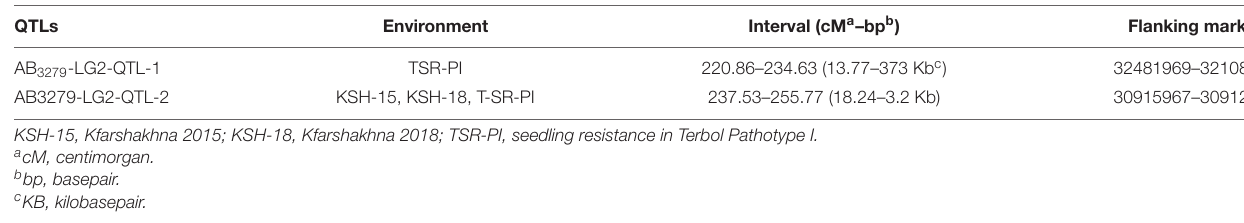
FIGURE 3 | Chromosomal distribution of single nucleotide polymorphism (SNP) markers in the chickpea genome, where (A) is the density of the AB 482 population (per 1 Mbp), (B) is the density of the AB 3279 population (per 1 Mbp), and (D) is the marker logarithm of odds (LOD) score (red points) only for AB 3279 . TABLE 4 | Quantitative trait loci (QTLs) associated with AB resistance identified in ILC3279 × ILC1929 chickpea population in chromosome CalG02.